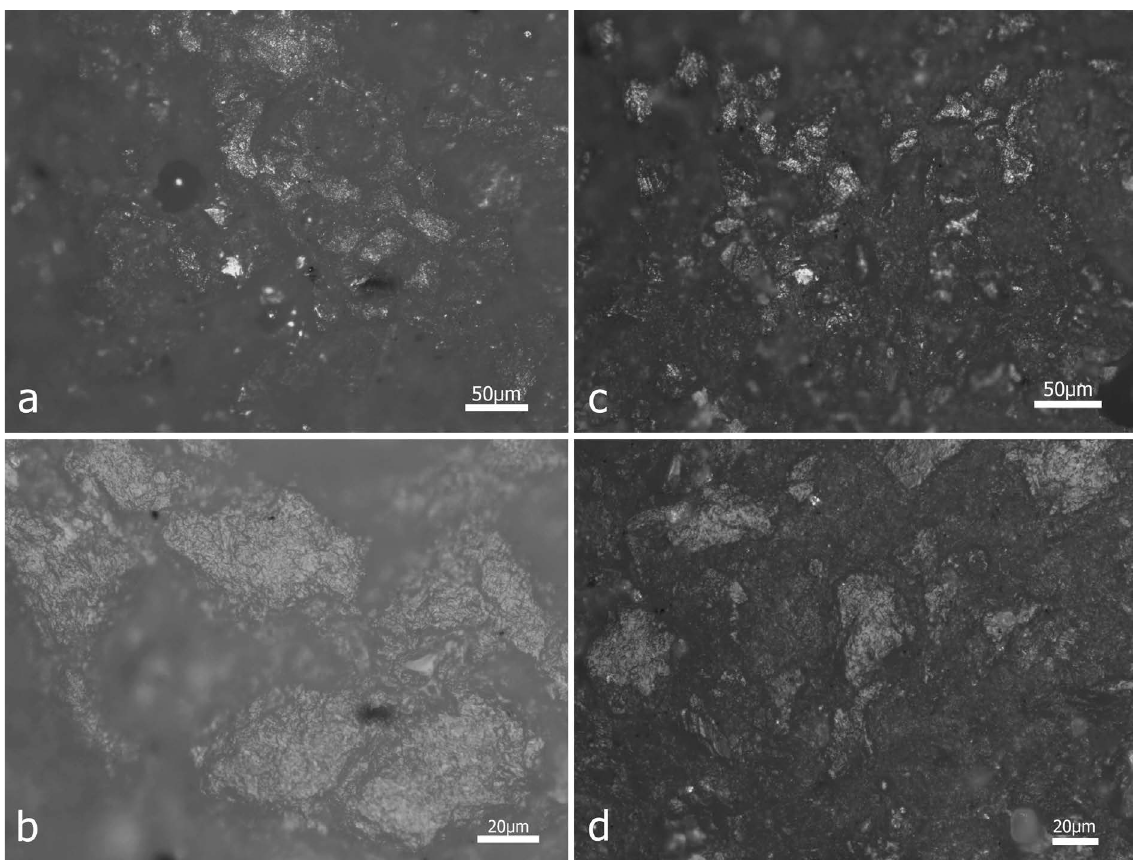
Figure 13. Traces of stone polishing on abraded stone as seen with the metallographic microscope; a-b experimental traces; c-d archaeological traces